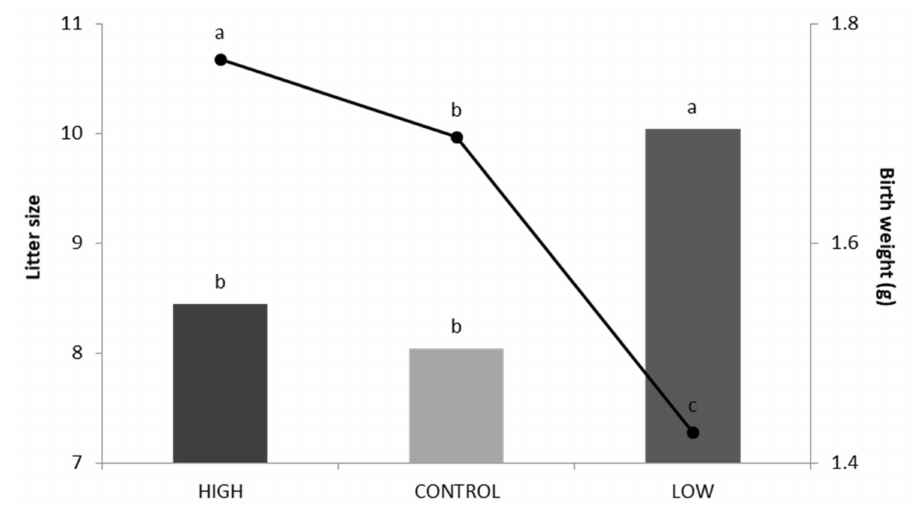
Figure 2. Litter size at birth (in bars) and birth weight (line) for the high line, control line, and low line. a,b,c show statistically significant di ff erences ( p <